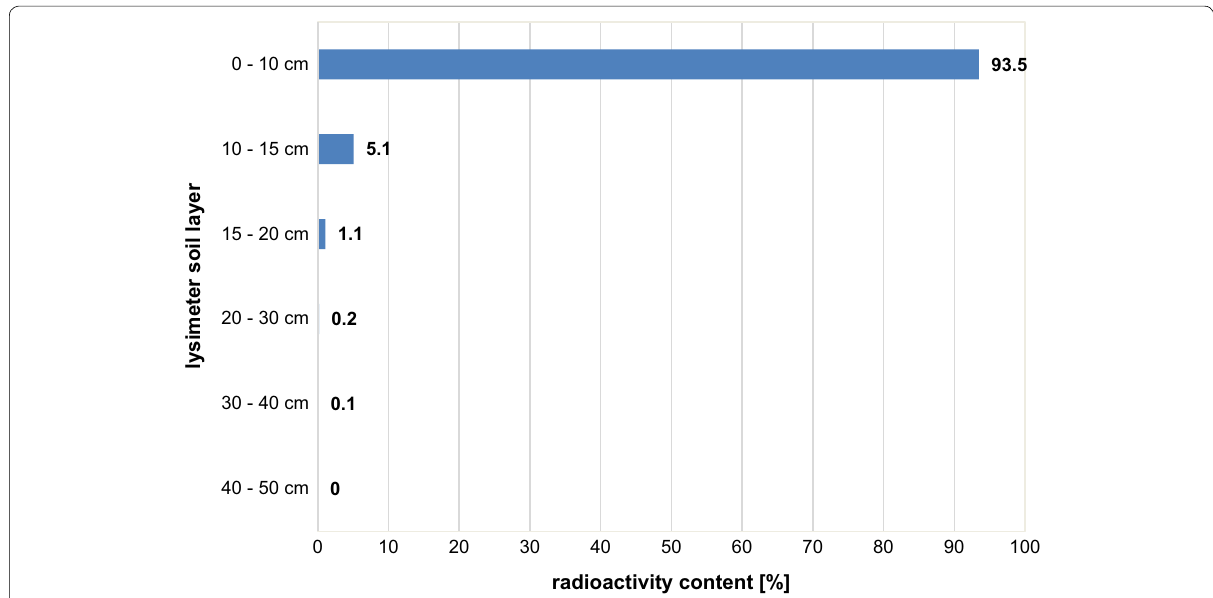
Fig. 6 Vertical radioactivity profile 3 years after treatment. Results in (% of total amount present at 1095 DAT)